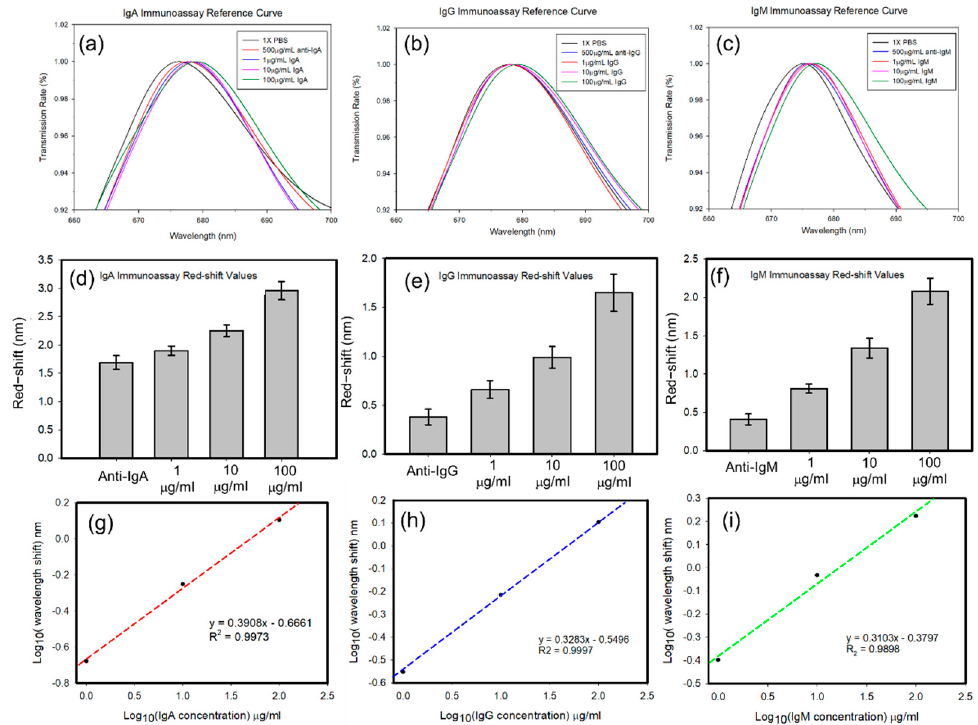
Figure 6. Resonant spectra of the different concentration of ( a ) immunoglobulin A (IgA), ( b ) IgG, and ( c ) IgM. Red-shift values of the different concentration of ( d ) IgA, ( e ) IgG, and ( f ) IgM. Linear regression of sensing results of ( g ) IgA, ( h ) IgG, and ( i ) IgM.